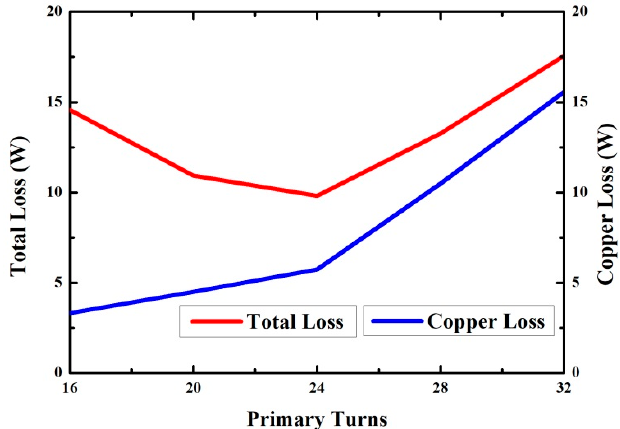
Figure 14. Copper loss and total loss.